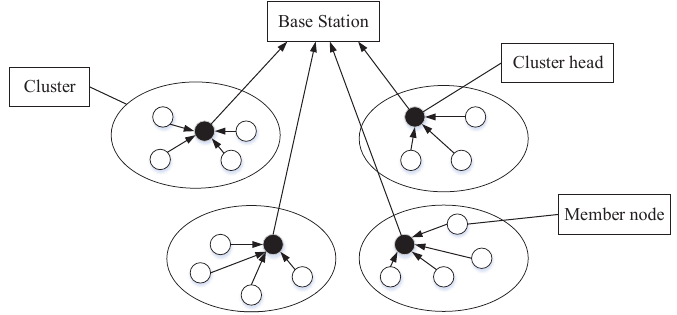
Figure 1. Cluster based directional sensor